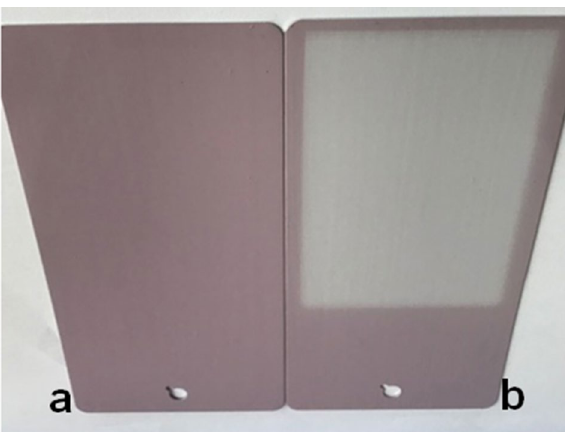
Figure 1. Colour fastness of the dye I -APU film under UV exposure ( a ) initial film; ( b ) after 414 h.